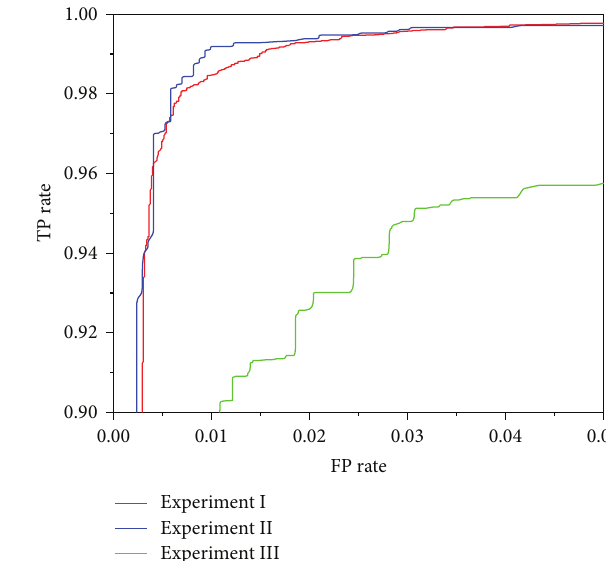
Figure 4: ROC curves for random forest (filter) classification algo- rithm.